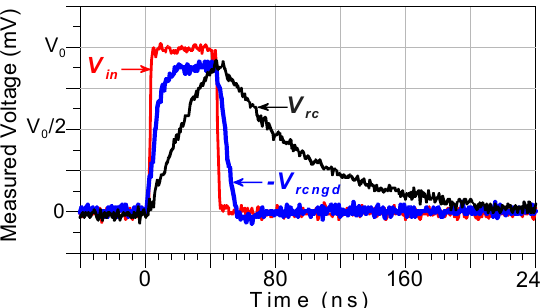
Figure 19: Time-domain measured results for the input square wave pulse with V = 1 V with 25-Msym/s rate, 2 ns 0 rise- and